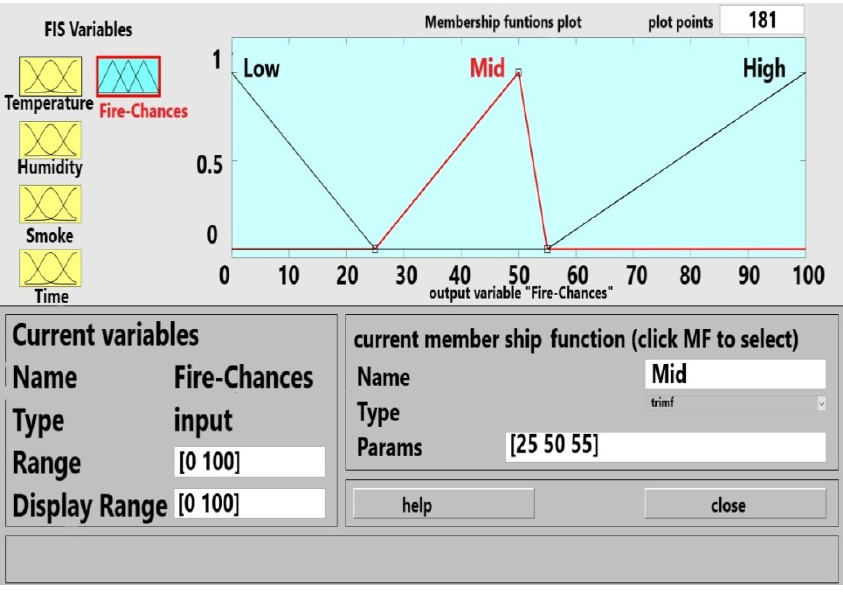
Figure 21. Membership Function for Fire Chances.